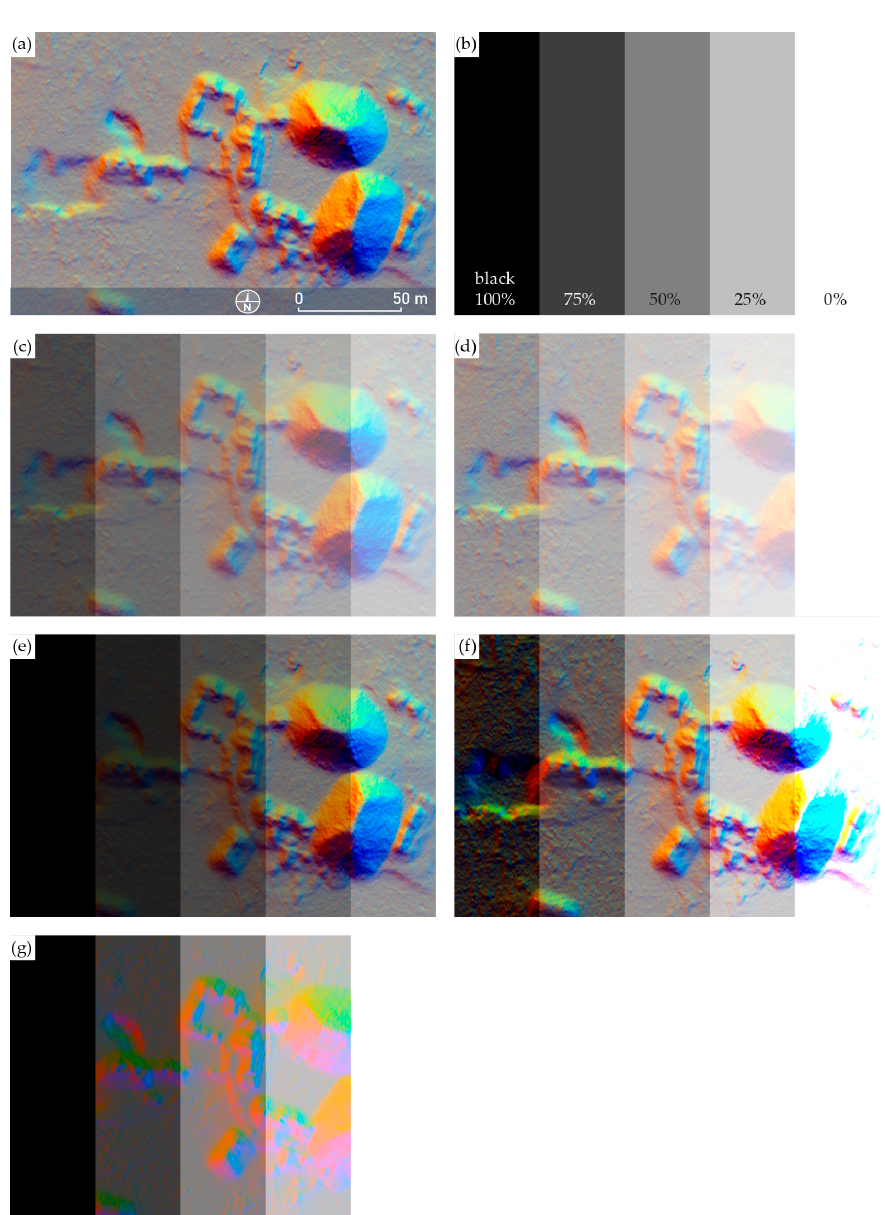
Figure 6. The effect of various blend modes. ( a ) The bottom (base) layer for blending shows the north-eastern complex in Chactún with two pyramidal structures. ( b ) The top layer is composed of rectangles with a varied degree of blackness. ( c ) Normal blend mode makes the foreground transparent (50% opacity). ( d ) Screen lightens the image. Black is neutral, white is opaque. ( e ) Multiply multiplies the luminance levels of the top layer’s pixels with the pixels in the layers below. Black is opaque, white is transparent. ( f ) Overlay enhances visibility of dark and bright areas. 50% gray is neutral. ( g ) Luminosity keeps the luminance of the top layer and blends it with the color of the combined view of the layers below. On a good grayscale printer, (b) and (g) should look the same.